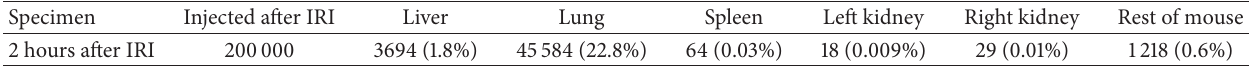
Table 1: Number of detected MSC 2 hours after hepatic